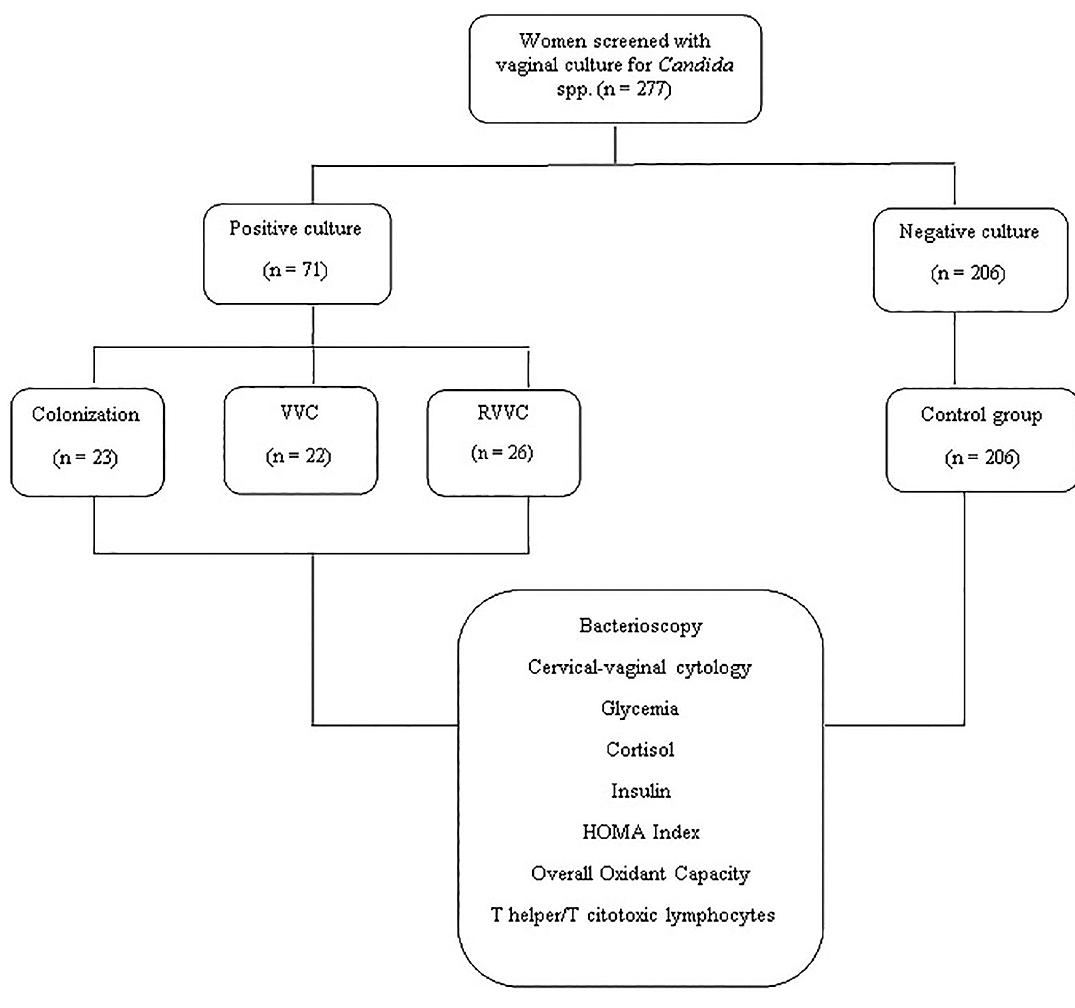
Fig 1. Flow chart of the study.